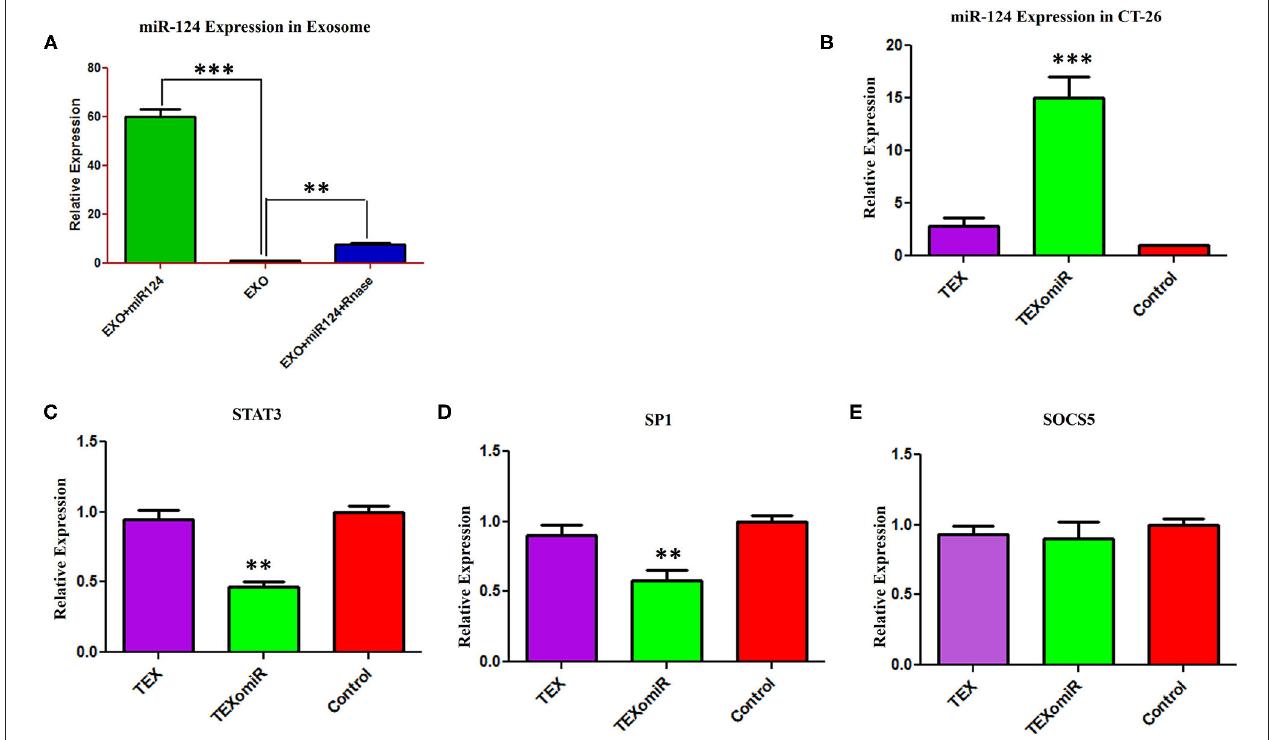
FIGURE 3 | Efficient delivery of miR-124-3p into exosomes and in vitro evaluation of the efficacy of miR-124-enriched tumor exosomes (TEXs). (A) For delivery of miR-124 mimic into TEX, modified calcium chloride transfection method was applied. To determine the encapsulation efficiency, exosome was reisolated and treated with one unit of RNase A for digestion of unloaded miRNAs. Subsequently, miRNA samples were isolated from purified exosomes, and the expression of miR-124-3p in exosomes was detected using quantitative RT-PCR. U6 snRNA was used as an internal control. (B) CT-26 cell lines treated with TEXomiR or TEXs, and the relative expression levels of miR-124 (C) STAT-3, (D) SP1, and (E) SOCS5 were measured using real-time PCR. Successful overexpression of miR-124 and dowregulation of the expression of STAT-3 and SP1 was verified in CT-26 cells that were treated with TEXomiR. The data are presented as mean ± SD. ** P < 0.01 and *** P < 0.001.